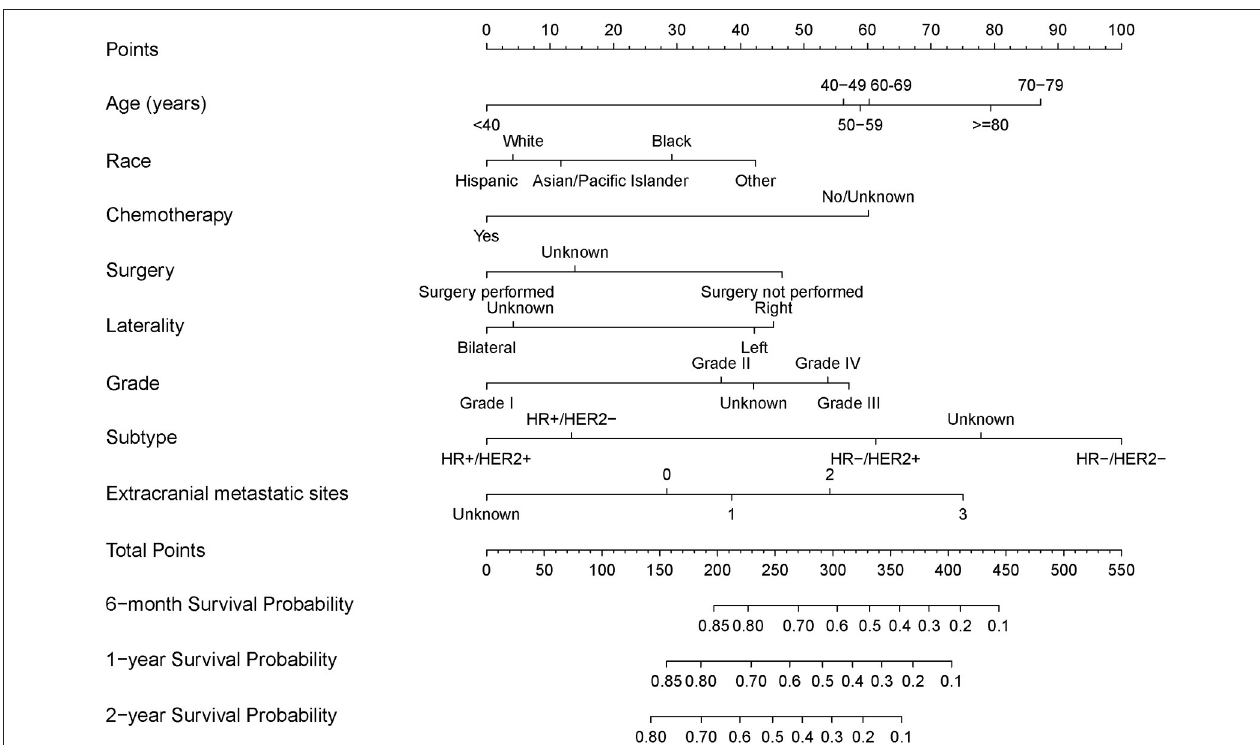
FIGURE 1 | Nomograms for predicting 6-month, 1-year, and 2-year overall survival (OS) of breast cancer patients with brain